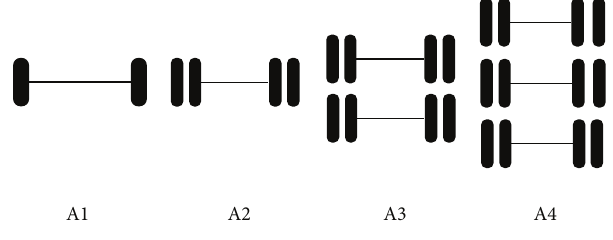
Figure 6: Common axle types [26, 27].